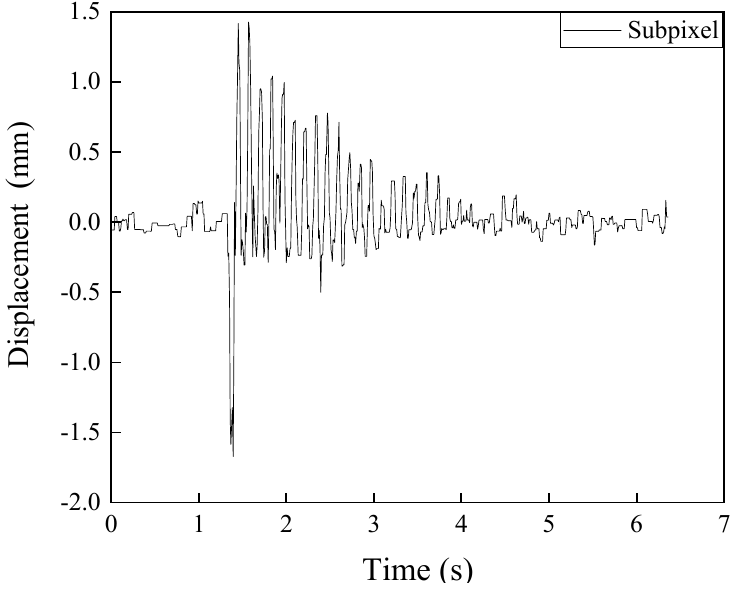
Figure 11. Vibration of street sign using subpixel image processing.